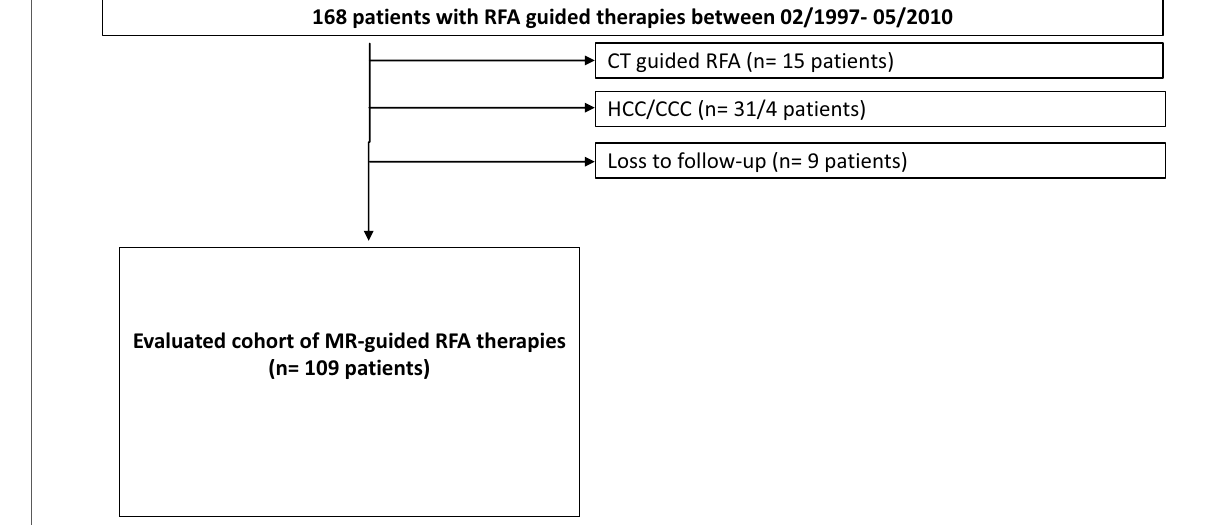
Fig. 1 Overview of the whole study cohort with 109 included patients, treated with MRI based RFA for liver metastases